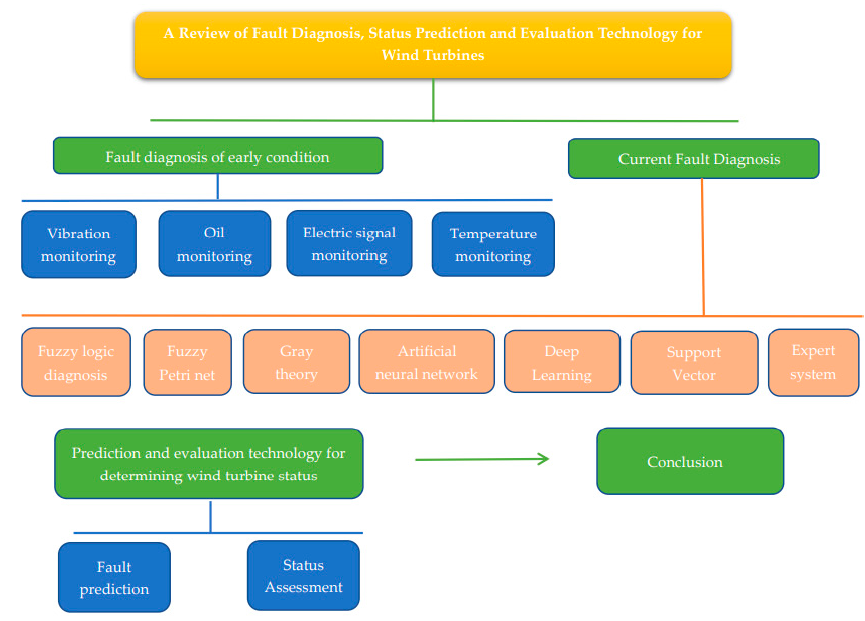
Figure 3. Framework of the present